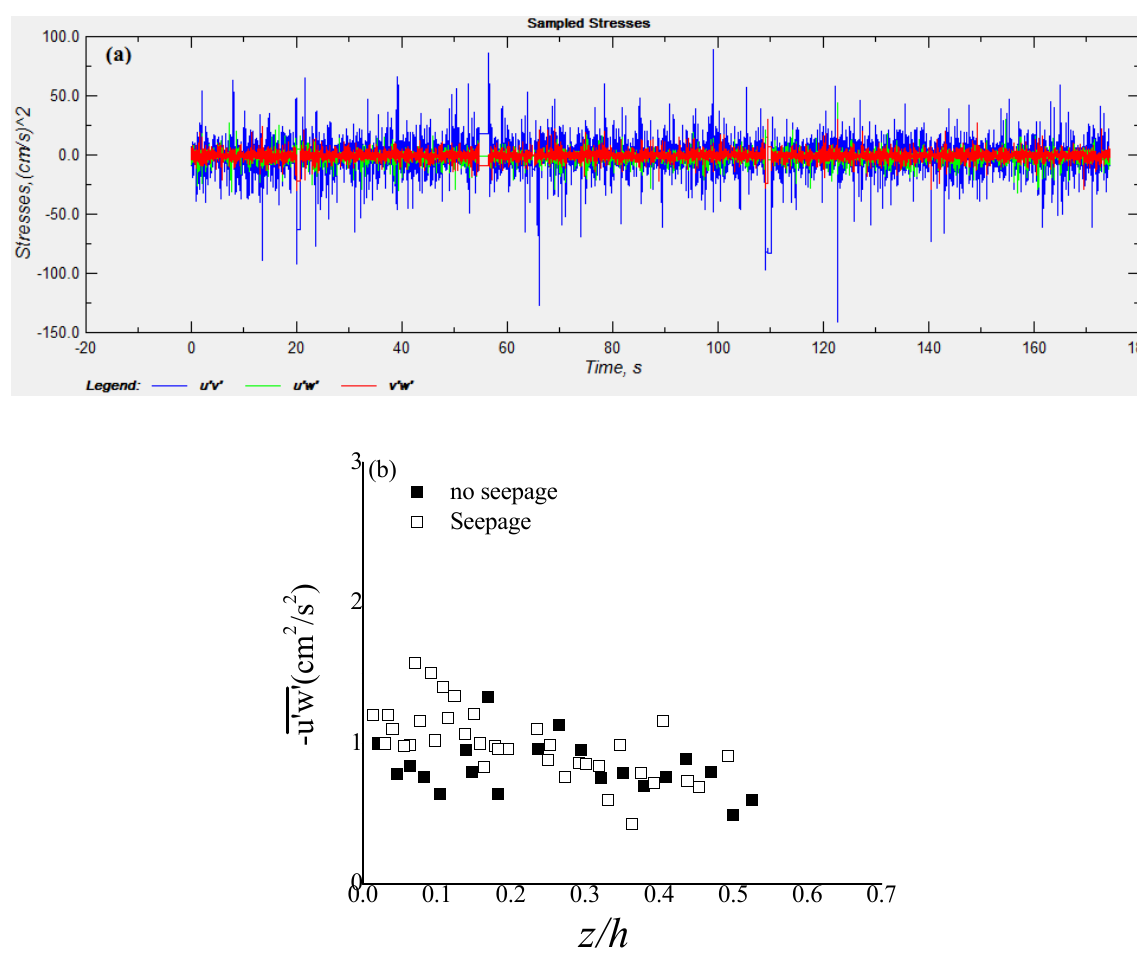
Figure 6. ( a ) Instantaneous RSS data trend at z = 0.05 h and ( b ) vertical profiles of RSS for all experiments in this study.